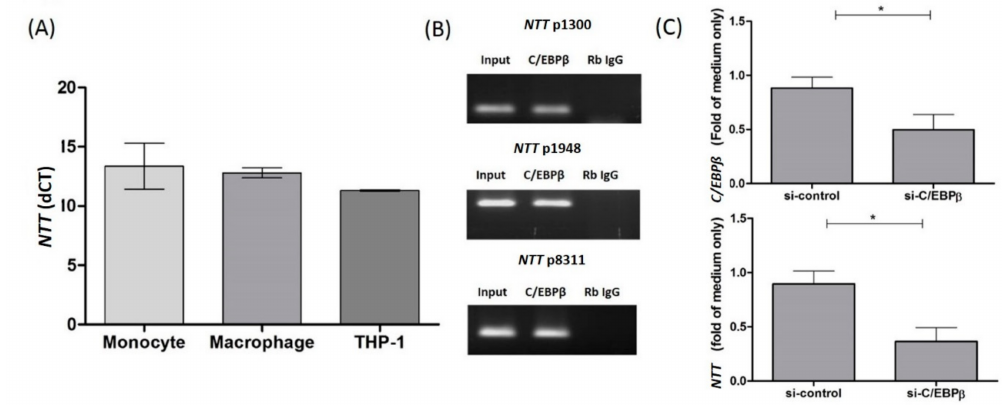
Figure 1. Expression of noncoding transcript in T cells ( NTT ) in immune cells and regulation of NTT during lipopolysaccharide (LPS) stimulation. ( A ) NTT is expressed in human primary monocytes, monocyte-derived macrophages, and THP-1 cells; n = 3, bars represent mean ± SEM. ( B ) THP-1 cell nuclear lysates were fixed and immunoprecipitated by anti-C/EBP β or isotype control IgG antibody (ChIP), and the antibody-bound DNA sequences of three positions of NTT promoter were detected by PCR and gel electrophoresis; here is a representative graph of three independent experiments, showing binding of C/EBP β . ( C ) Knockdown of C/EBP β in THP-1 cells by si-RNA resulted in lower expression levels of NTT ; n = 5, bars represent mean ± SEM. *: p < 0.05 by Wilcoxon signed rank test.